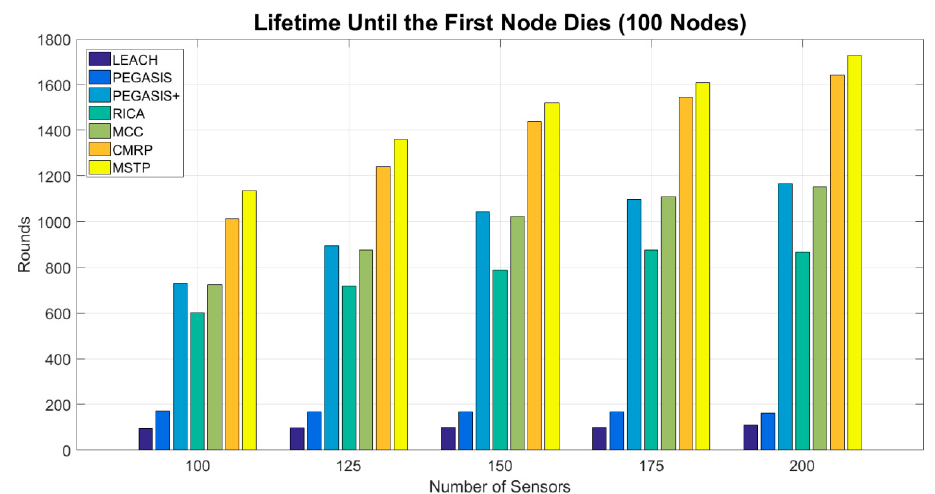
Figure 4. Lifetime until the first node dies.